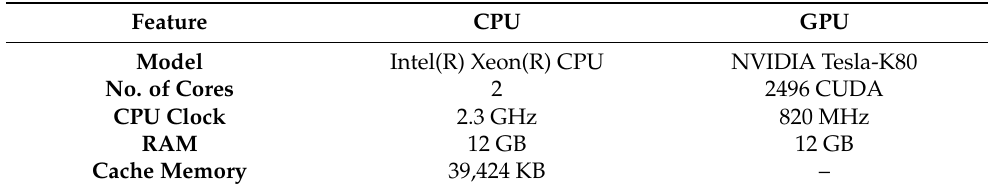
Table 6. Server Hardware